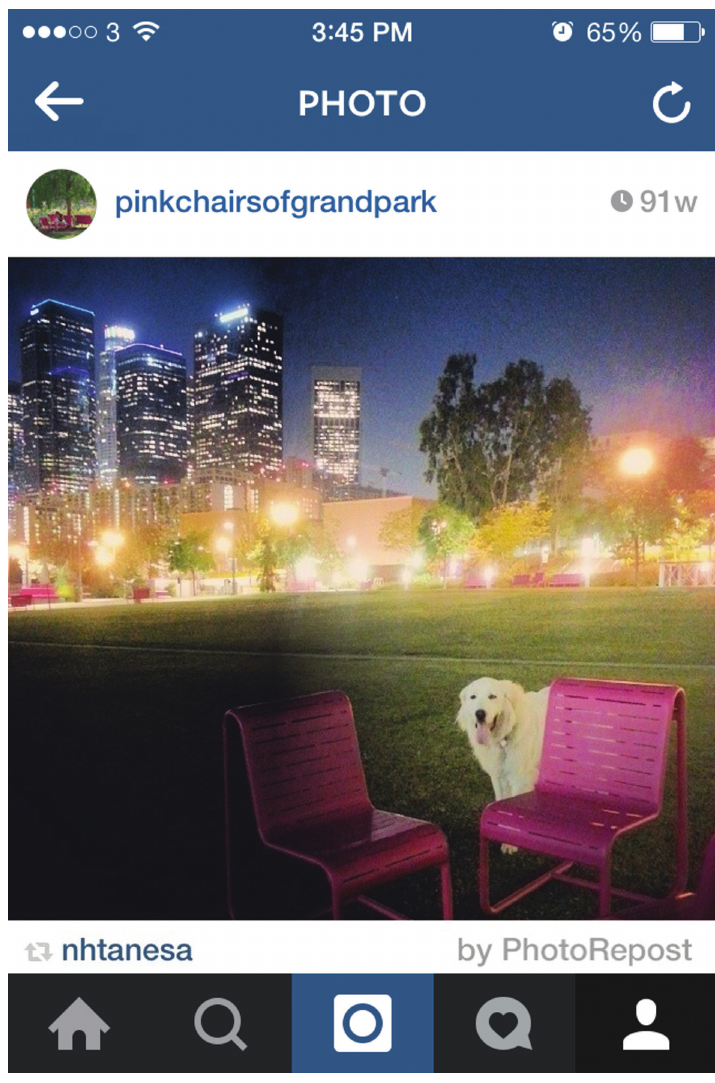
Figure 4: Screen shot of re-posted Instagram image, originally by